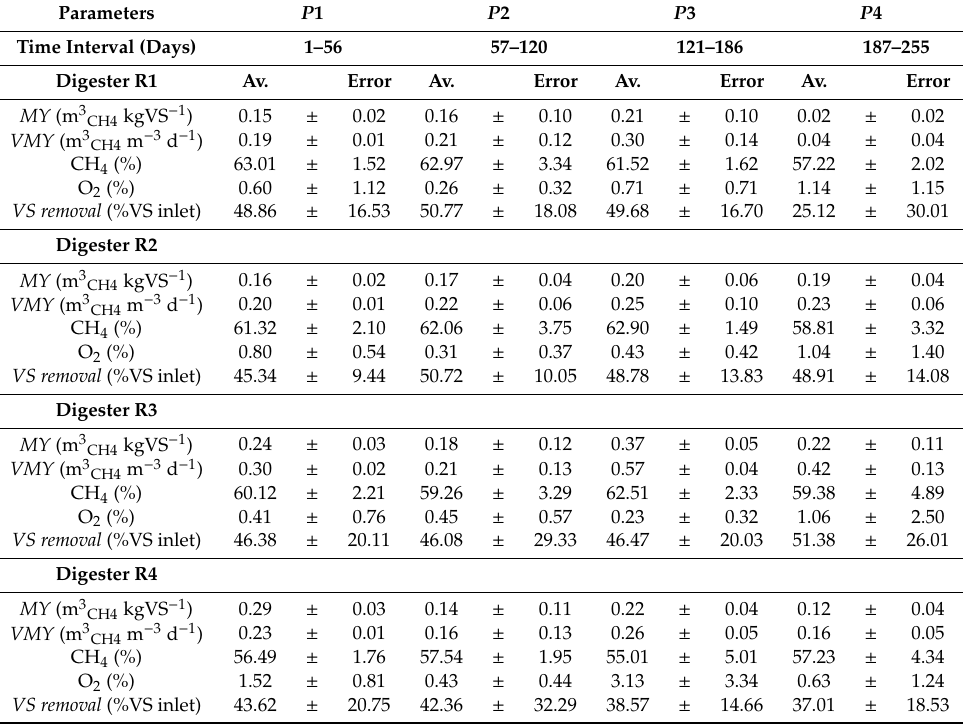
Table 3. Control parameters (methane productivity and yield, and organic matter